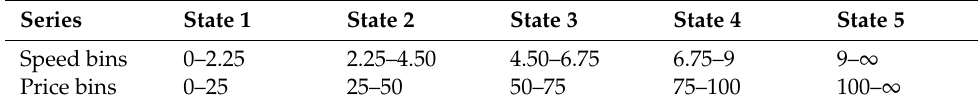
Table 4. Discretisation bins for wind speed and